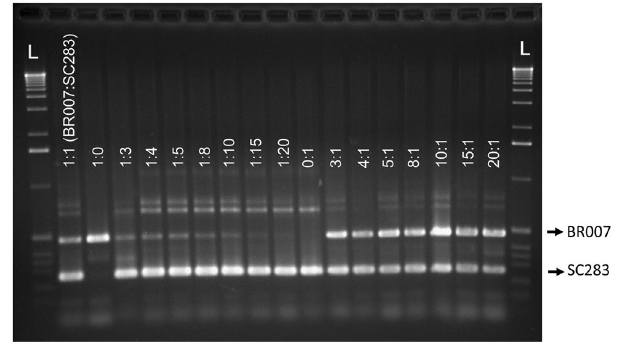
Figure 3. Detection sensitivity upon DNA pooling for the four-primer 6083 ARMS. DNA from the sorghum lines, BR007 (Al sensitive) and SC283 (Al tolerant) were mixed in equal (1:1) proportions (BR007:SC283) or so that the BR007 (1:3 to 1:20) or the SC283 (3:1 to 20:1) alleles were under-represented in the DNA pool at different proportions. Unmixed DNA from BR007 (1:0) and SC283 (0:1), which are homozygous for the unfavorable and favorable alleles, respectively, were included as controls. L = 1Kb